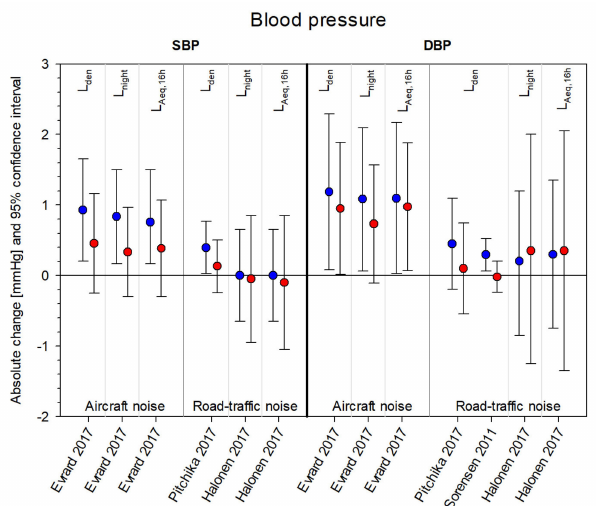
Figure 4. Sex/gender-specific effect estimates from studies with the cardiovascular outcome blood pressure changes. Effect estimates are displayed as absolute changes (mmHg) (blue = males, red = females) and 95% confidence intervals per 5 dB(A) increase in noise exposure (aircraft noise, road traffic noise) and grouped according to systolic and diastolic blood pressure changes (SBP, DBP) and noise indicator (L den , L night , L Aeq, 16 h ). Please note, some studies provided several estimates for different noise indicators per noise exposure and frequency